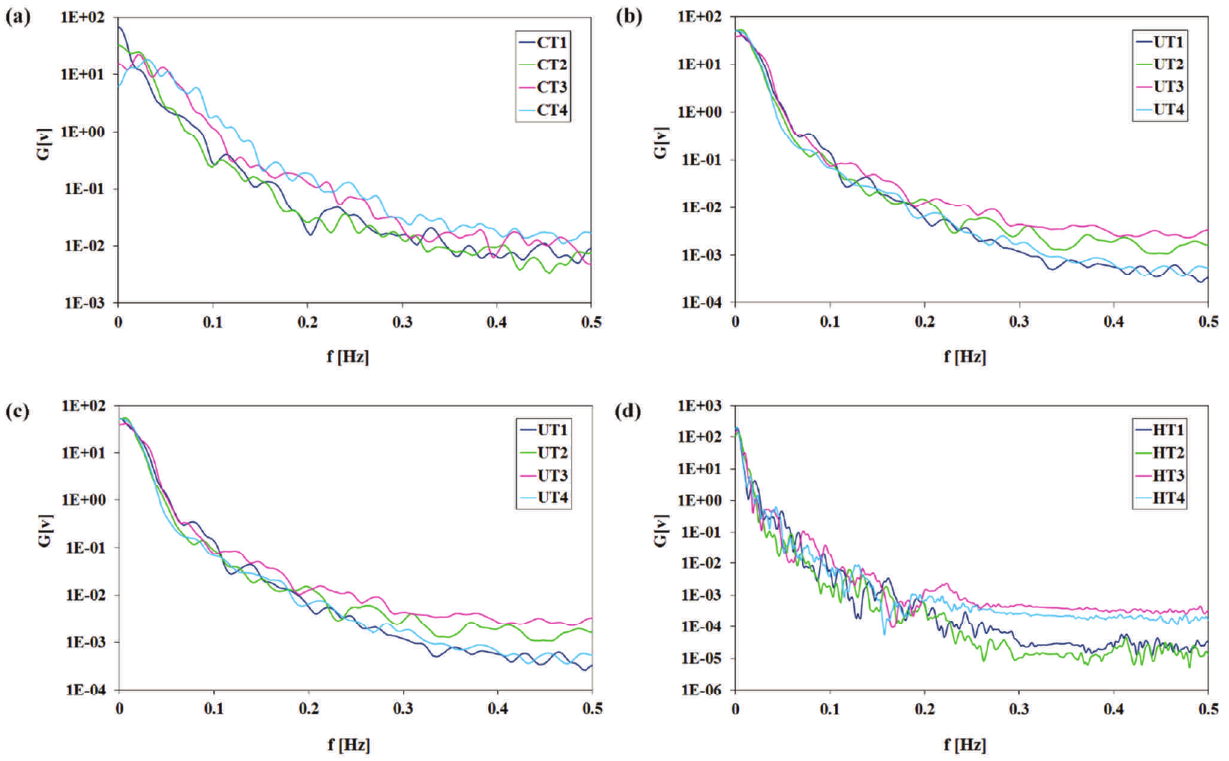
Fig. 5. The power spectral density of standardized velocity (G[v]) in the frequency domain (f) in the vehicle driving test cycles for: a) urban traffic conges- tions (CT); b) urban traffic (UT); c) extra-urban traffic (RT); d) high-speed traffic